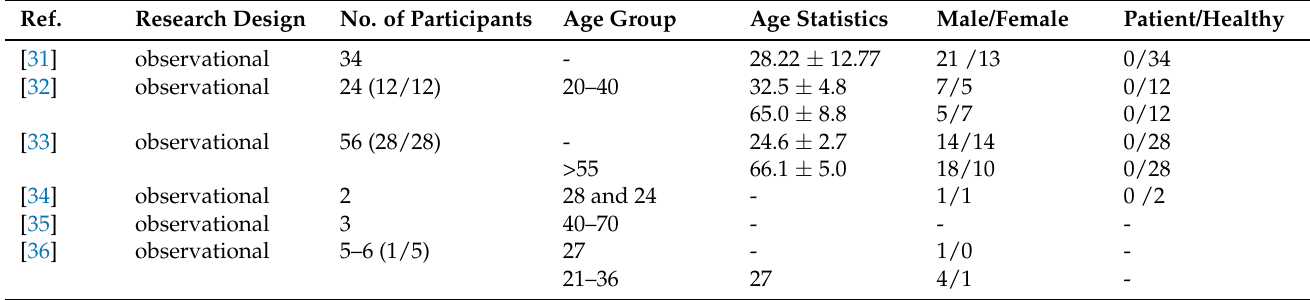
Table 1. Participant demographics for studies on gait and balance. - = no information.